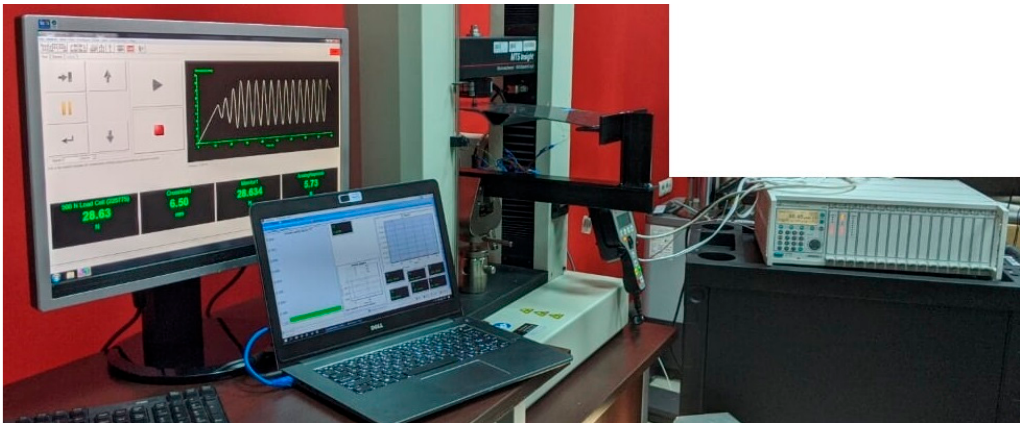
Figure 13. Experimental real-time testing of the ANN.